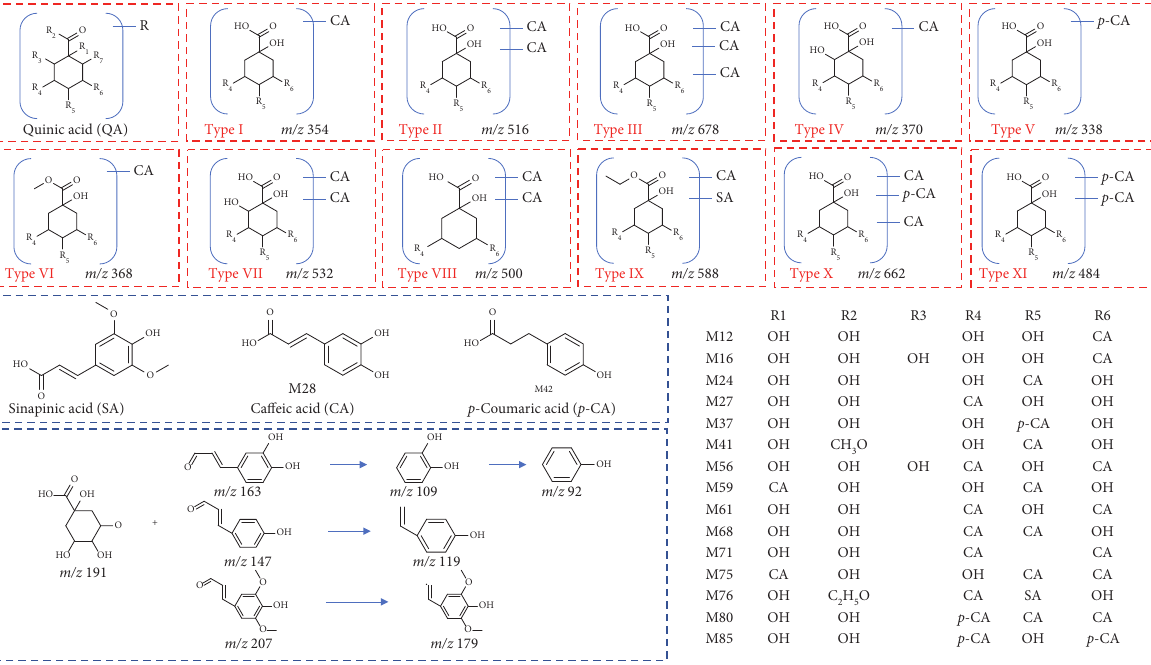
Figure 5: Chlorogenic acids in IRC. Quinic acid as the parent nucleus was formed mainly by introducing QA, SA, CA, and p -CA